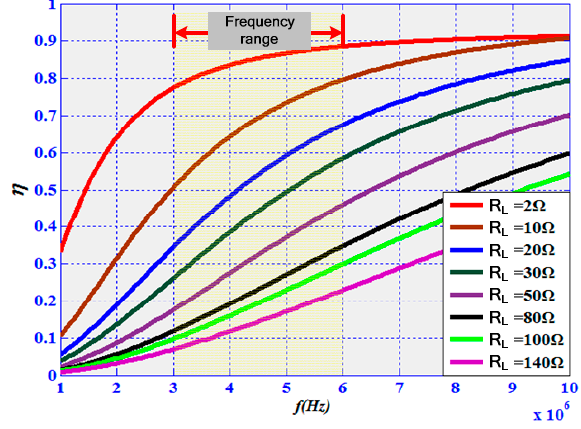
Figure 2. The efficiency varies with the resonant frequency under different resistance.